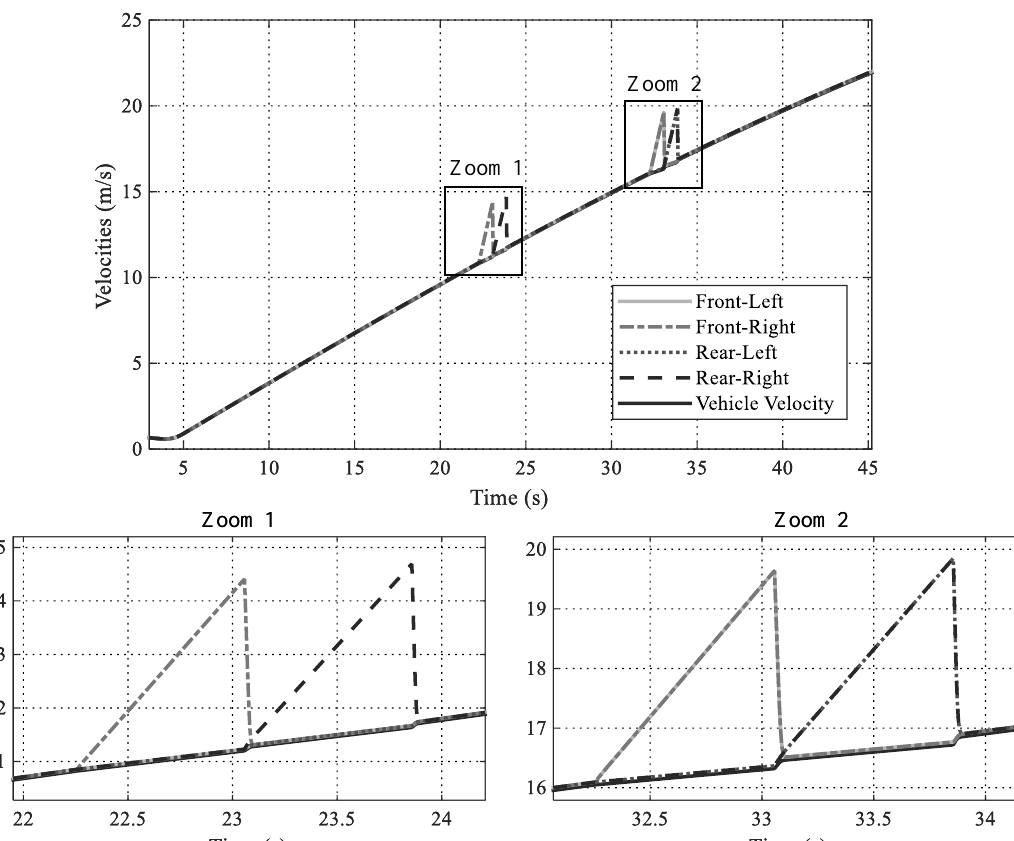
Figure 17. Velocity of Wheels and Vehicle for Scenario 2 and 3. The Zoom 1 is associated with Scenario 2 and the Zoom 2 is for Scenario